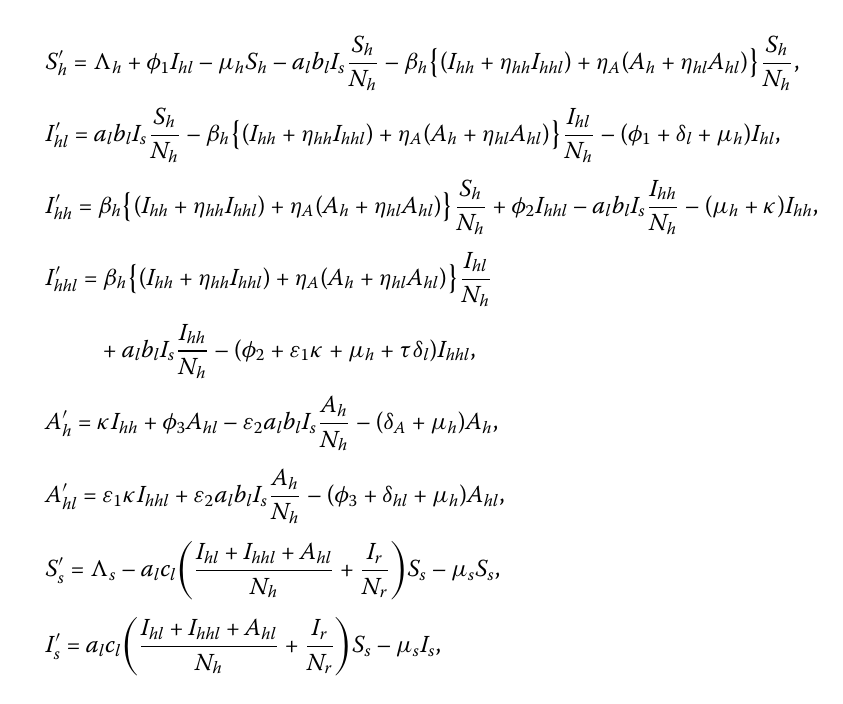
Fig. 1, the HIV/AIDS–VL co-infection model can be described by the following system of ordinary differential